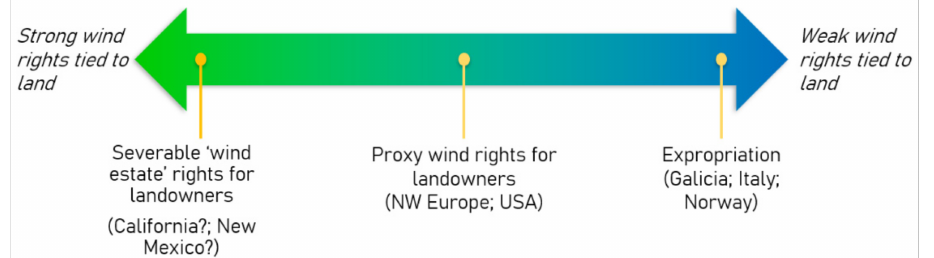
Figure 2. Spectrum indicating the strength of exclusive landowner rights from strongest (left) to weakest (right): formal legal wind estates for landowners, de facto ‘proxy’ wind rights for landowners, and possibility of expropriation. Source: